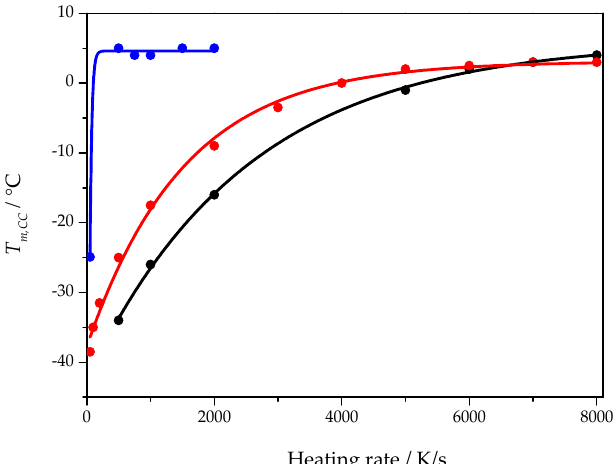
Figure 7. Cold crystallization peak temperature as a function of heating rate for three different samples of cross-linked PCL with 5% BPO. The blue curve was obtained from a sample with little to no nuclei. The black and red curves were obtained from two different samples with a large number of nuclei created before the heating scan.